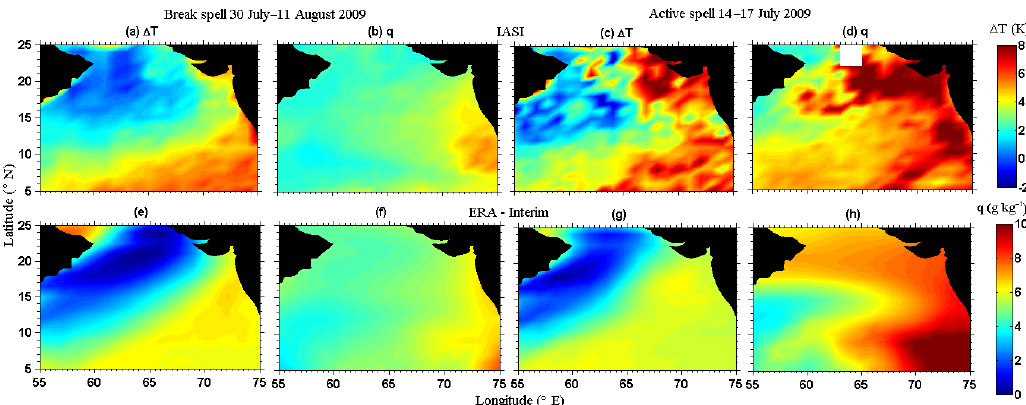
Figure 6. MI observed in (a) (cid:49)T and (b) q at 700hPa during break spells (30 July–11 August 2009) of the year 2009 by IASI. Panels (c) and (d) are the same as panels (a) and (b) but observed during active spells (14–17 July 2009). Panels (e–h) are the same as panels (a–d) but observed by ERA-Interim, respectively.